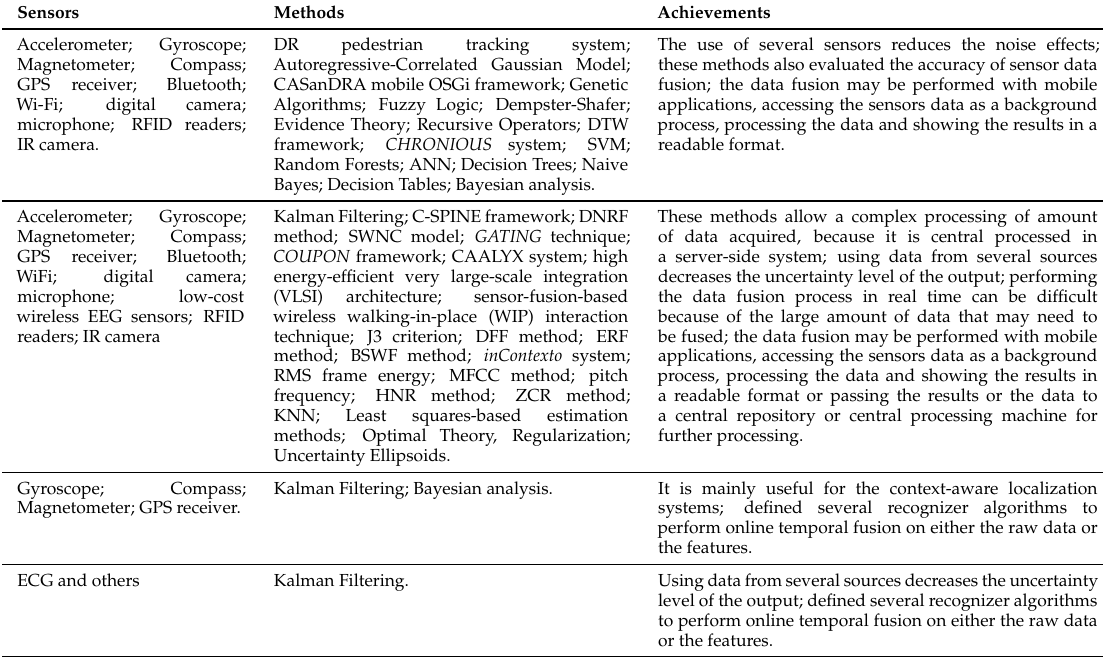
Table 6. Examples of sensor data fusion